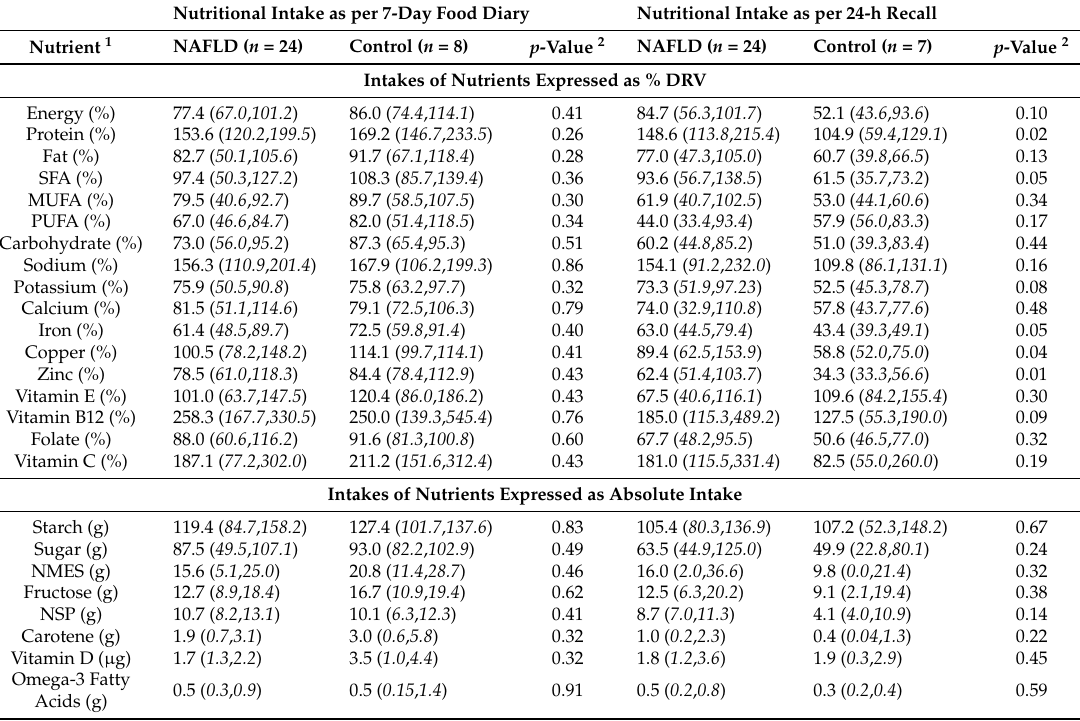
Table 2. Nutritional intakes recorded via participant completed 7-day food diary or 24-h recall expressed as % DRV or absolute intake.